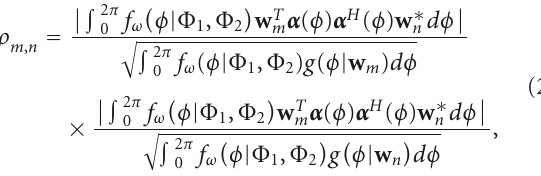
Figure 8: Complex correlation of beam patterns in the presence of a given angular distribution property of the